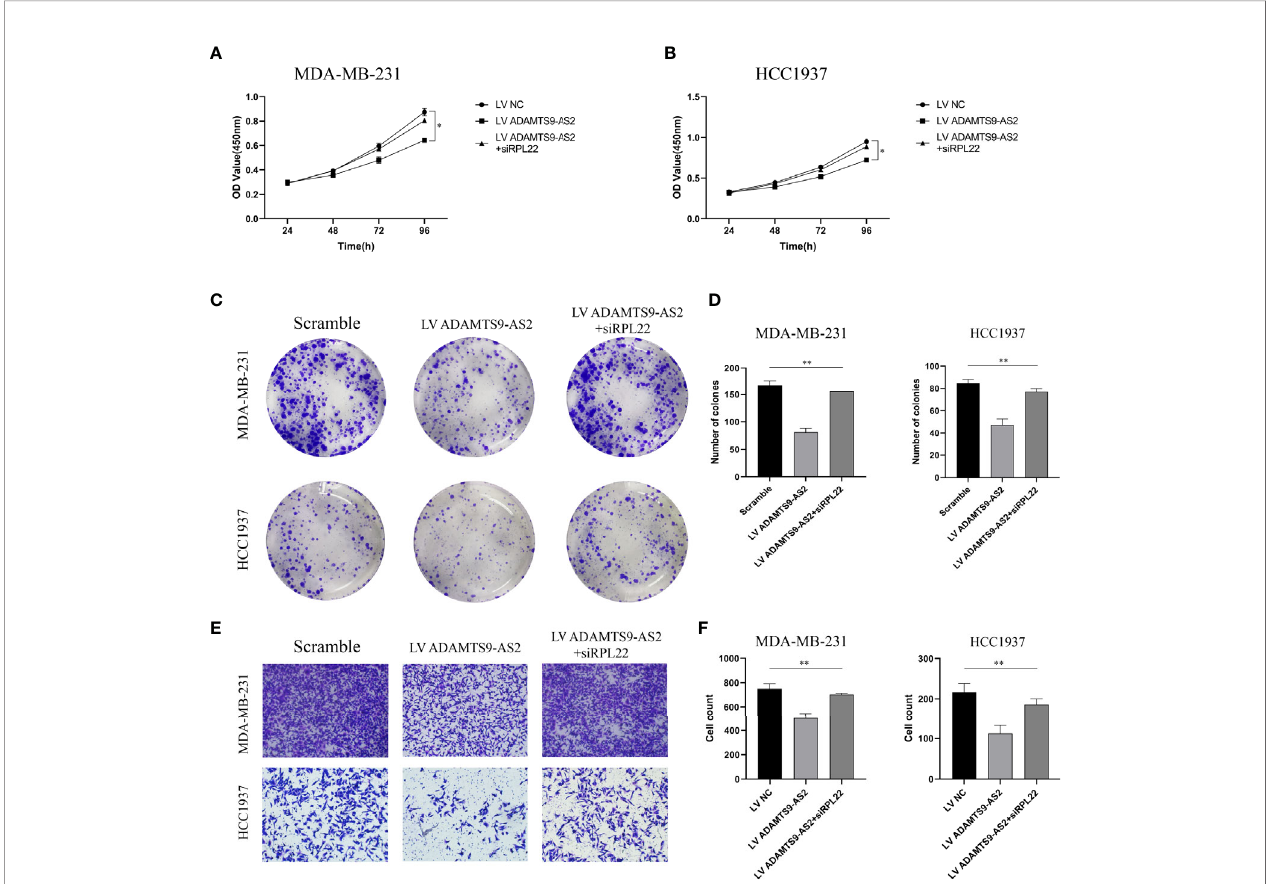
FIGURE 6 | ADAMTS9-AS2 regulates RPL22 to control TNBC progression through RPL22. (A – D) The cell proliferation was determined after transfection with LV ADAMTS9-AS2, ADAMTS9-AS2+siRPL22 and LV NC by CCK-8 and Colony formation assay. (E, F) The cell migration was determined after transfection by Transwell assay. *P < 0.05, **P <